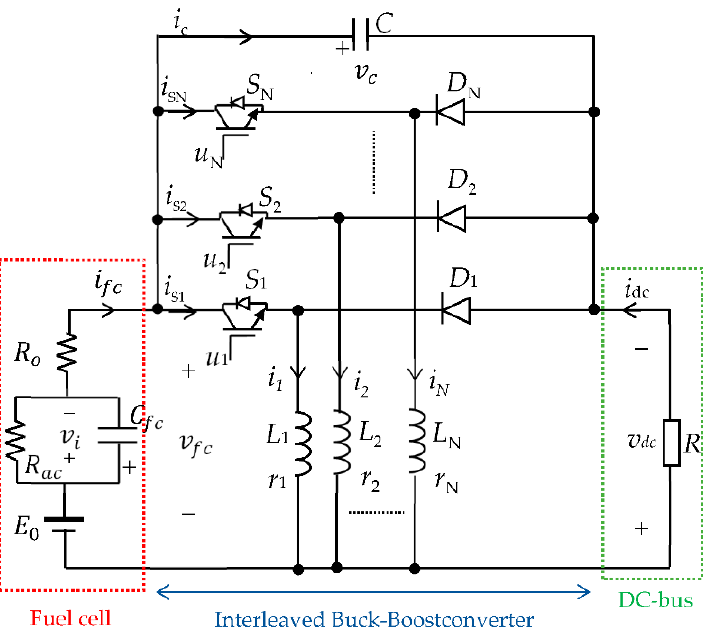
Figure 3. Fuel cell association with an interleaved Buck–Boost DC–DC converter (IBBC).